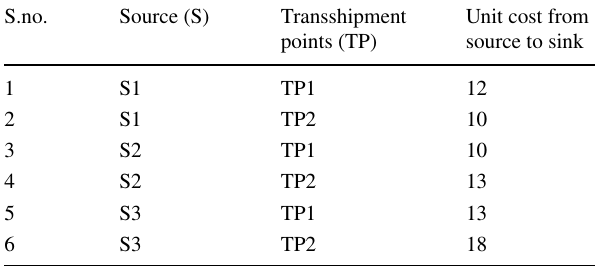
Table 2 Unit cost from source to